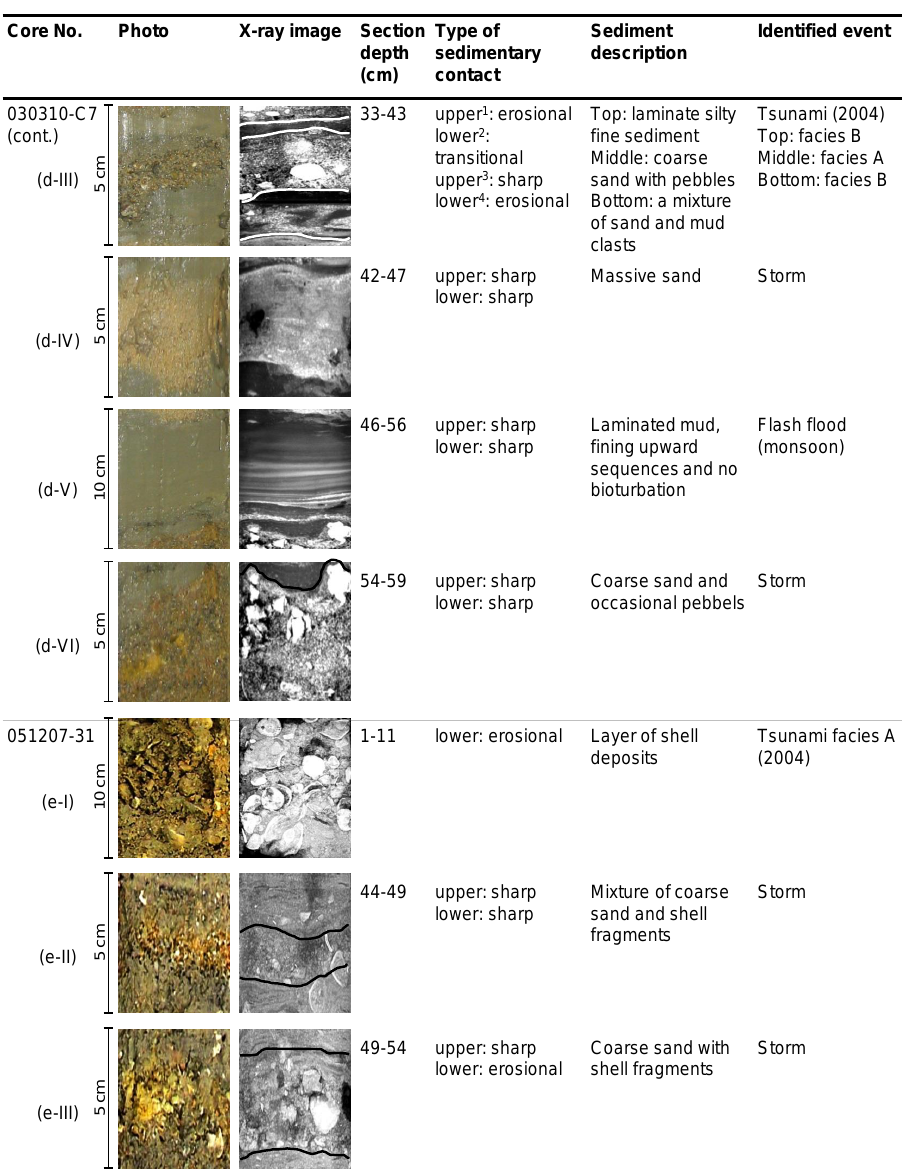
upper: sharp lower: erosional